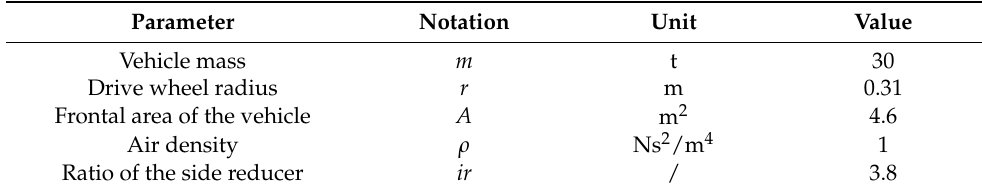
Table 1. Main parameters of the motor load simulation. Parameter Notation Unit Value Vehicle mass m Drive wheel